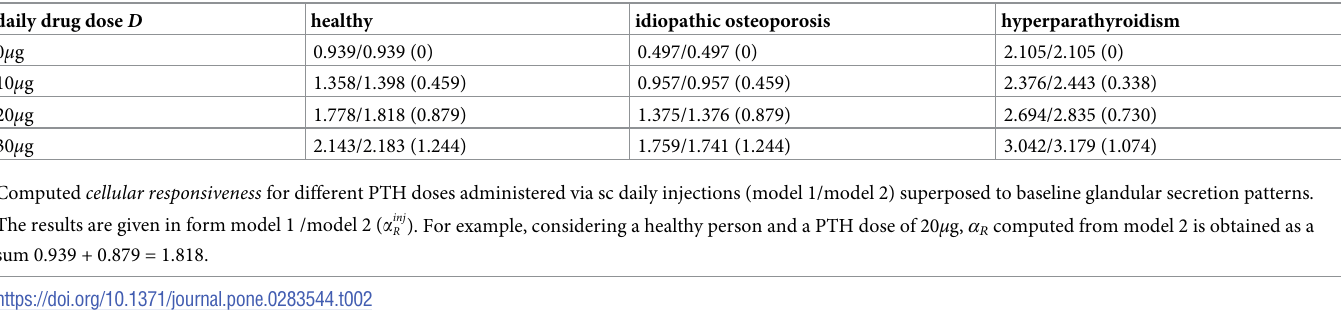
Table 2 indicates that both models produce nearly the same cellular responsiveness α